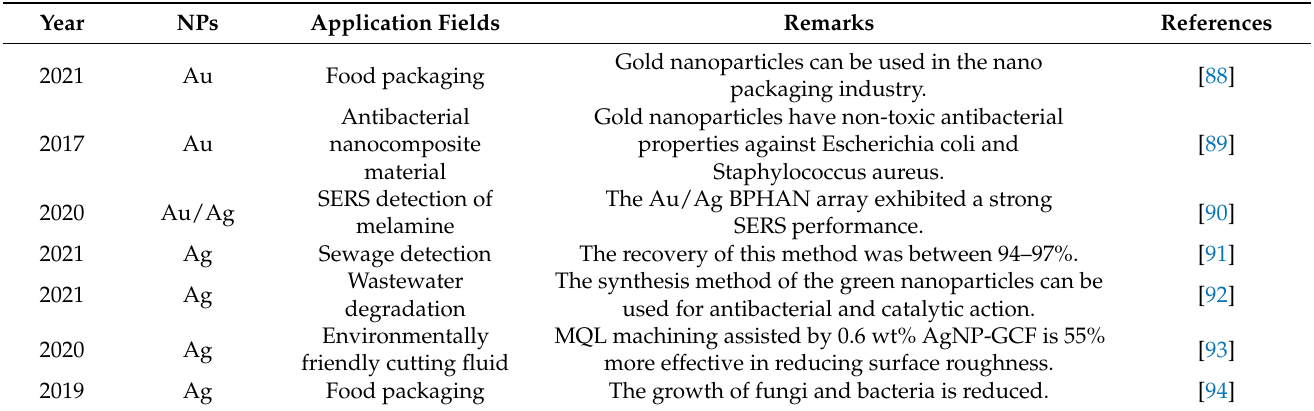
Table 3. Typical application of Au/Ag NPs in recent years grouped by NPs and application